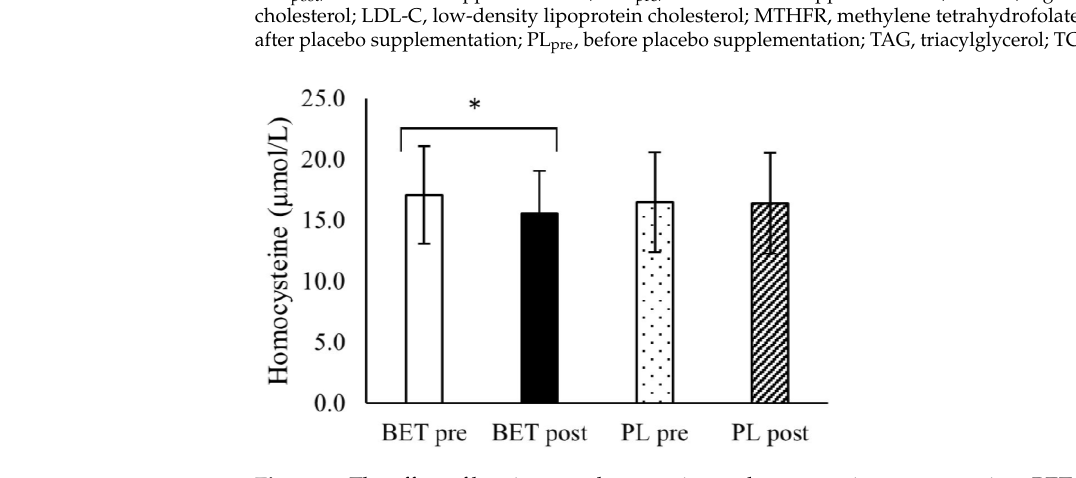
Table 4. The effect of betaine supplementation on lipid profile, as well as homocysteine and glucose concentrations in regard to MTHFR genotype and dose of betaine. MTHFR